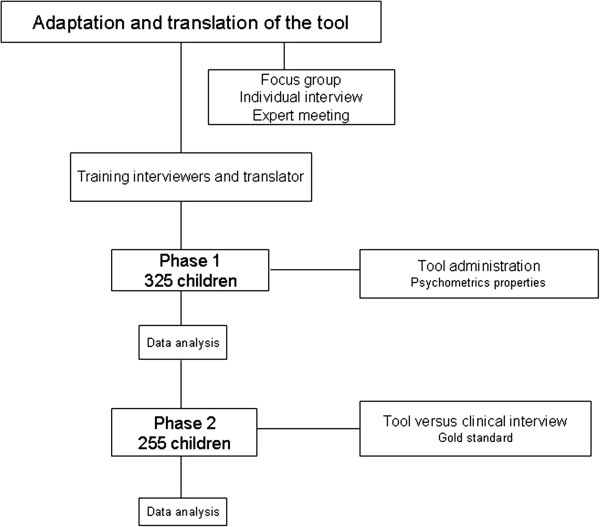
Study flow-chart.